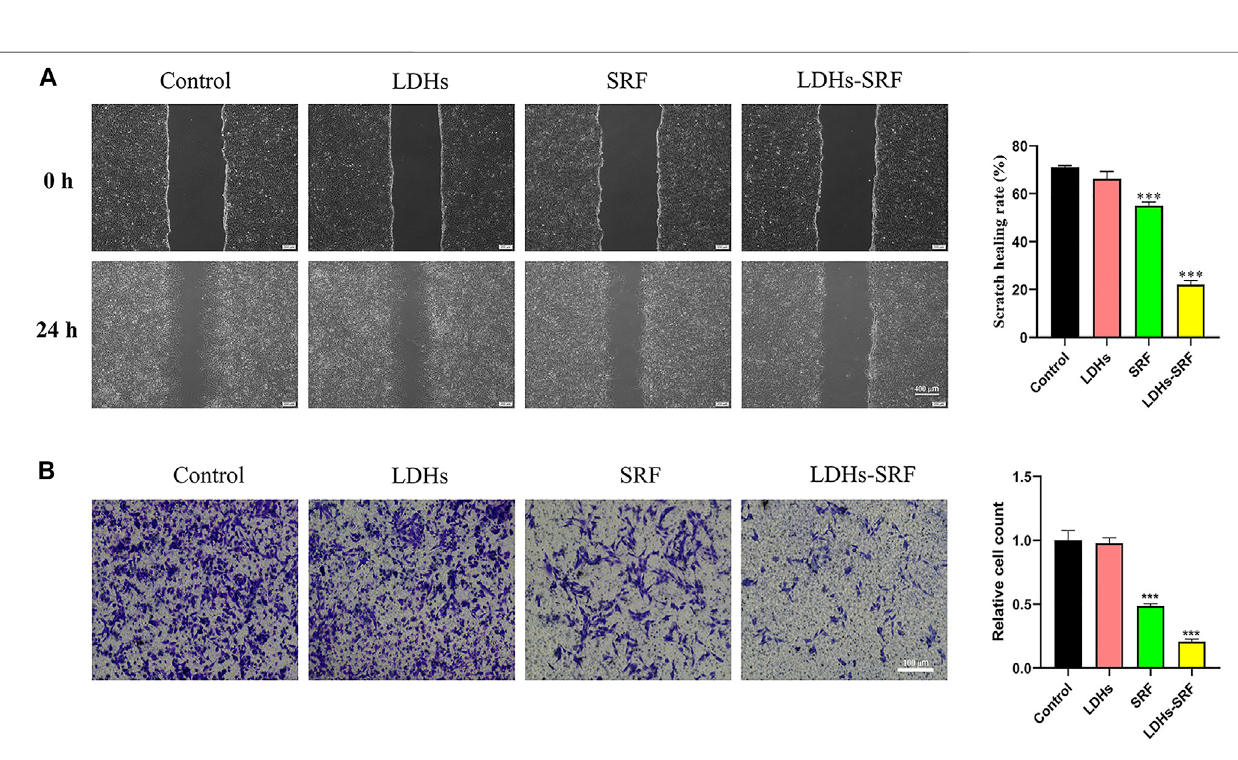
Frontiers in Bioengineering and Biotechnology |